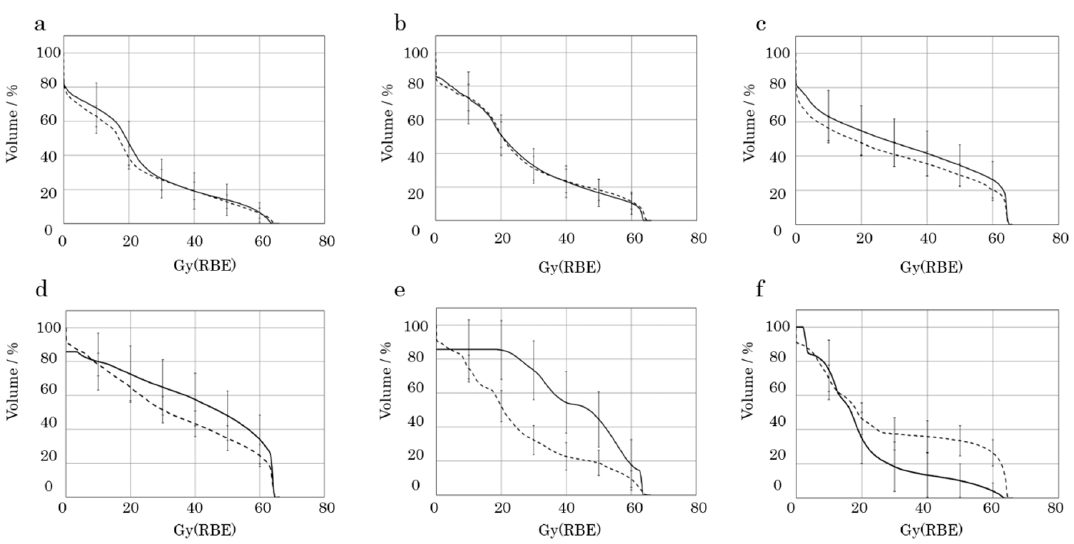
Figure 3. Comparison of dose − volume histograms and carbon ion radiotherapy-induced trismus. The vertical axis is the relative volume of the structure that received a higher dose than the absolute dose specified on the horizontal axis. ( a ) Masseter muscle, ( b ) temporal muscle, ( c ) medial pterygoid muscle, ( d ) lateral pterygoid muscle, ( e ) coronoid process, ( f ) mandible head. Continuous lines are with trismus, and dotted lines are without trismus.